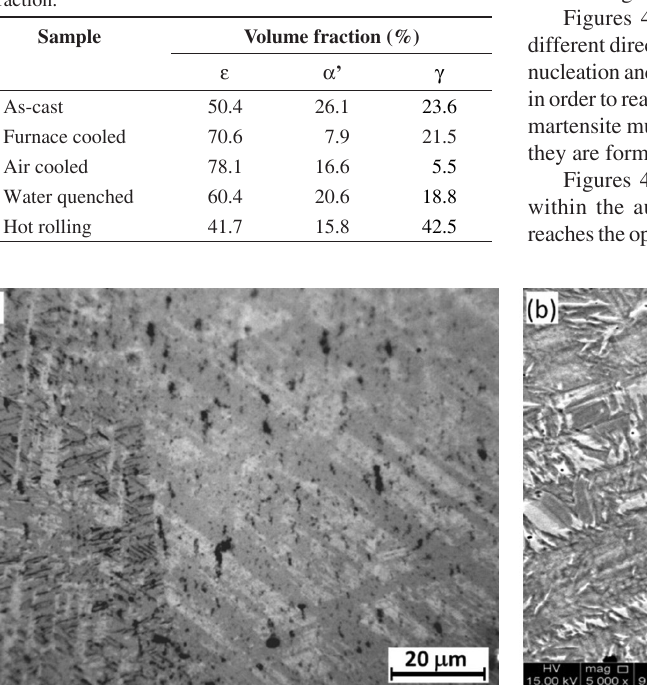
Figure 3. (a) Optical and (b) scanning electron micrographs of the as-cast sample. Samples were etched with 4%